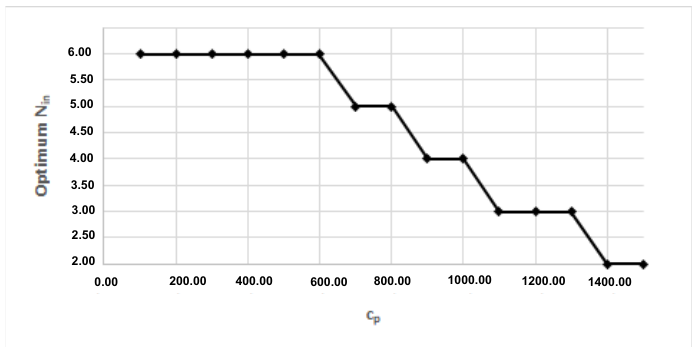
Figure 13. Variations of optimum N in per c p .